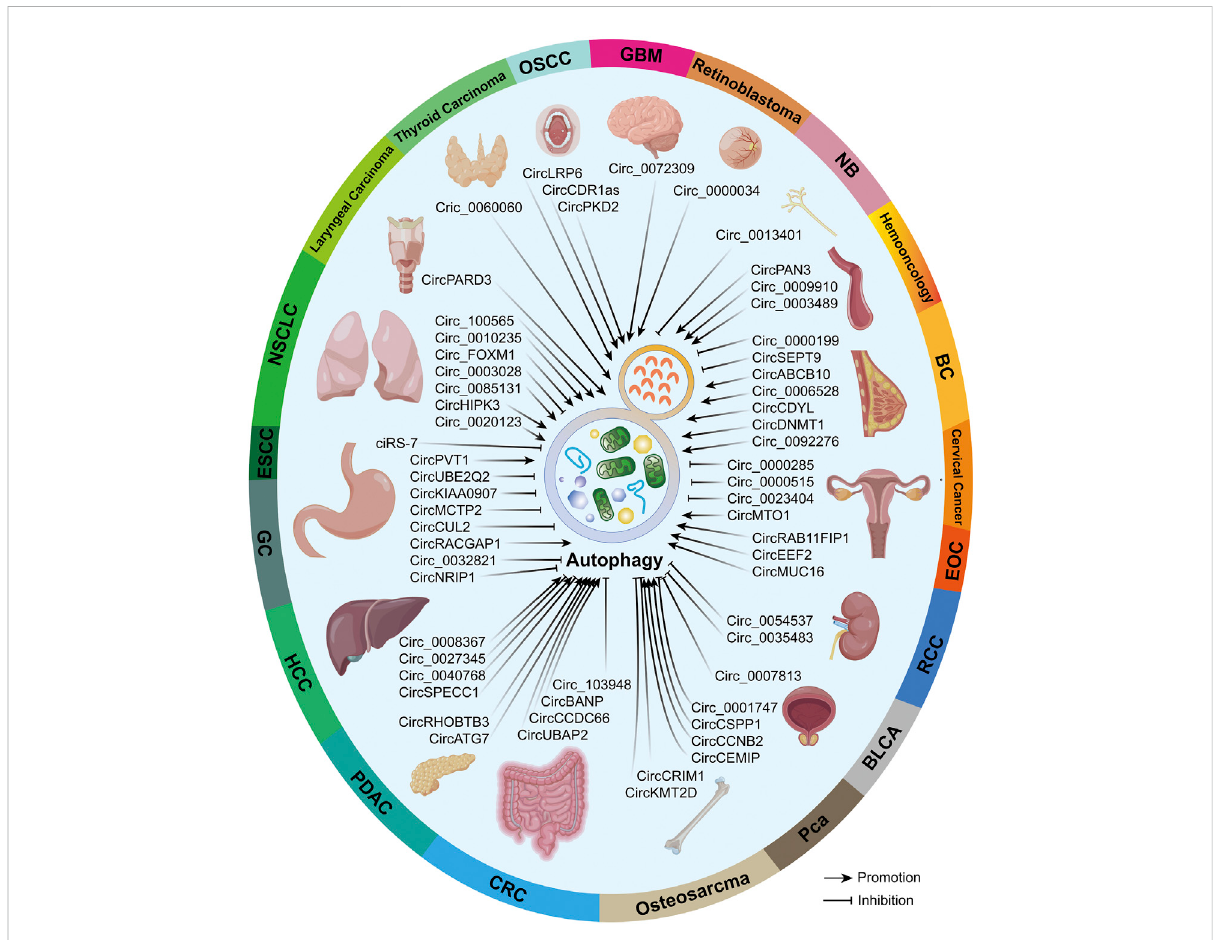
FIGURE 3 Indifferentmalignancies,circRNAsthatcanregulateautophagyweresummarized.Partialmaterialswereobtainedfromtheonlinedrawingtool (https://www. fi gdraw.com), with an authorization code